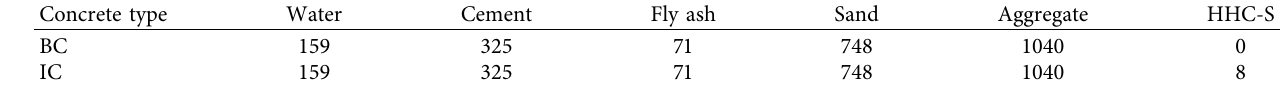
Table 6: Experimental concrete mix ratio ( kg/m 3 ) .